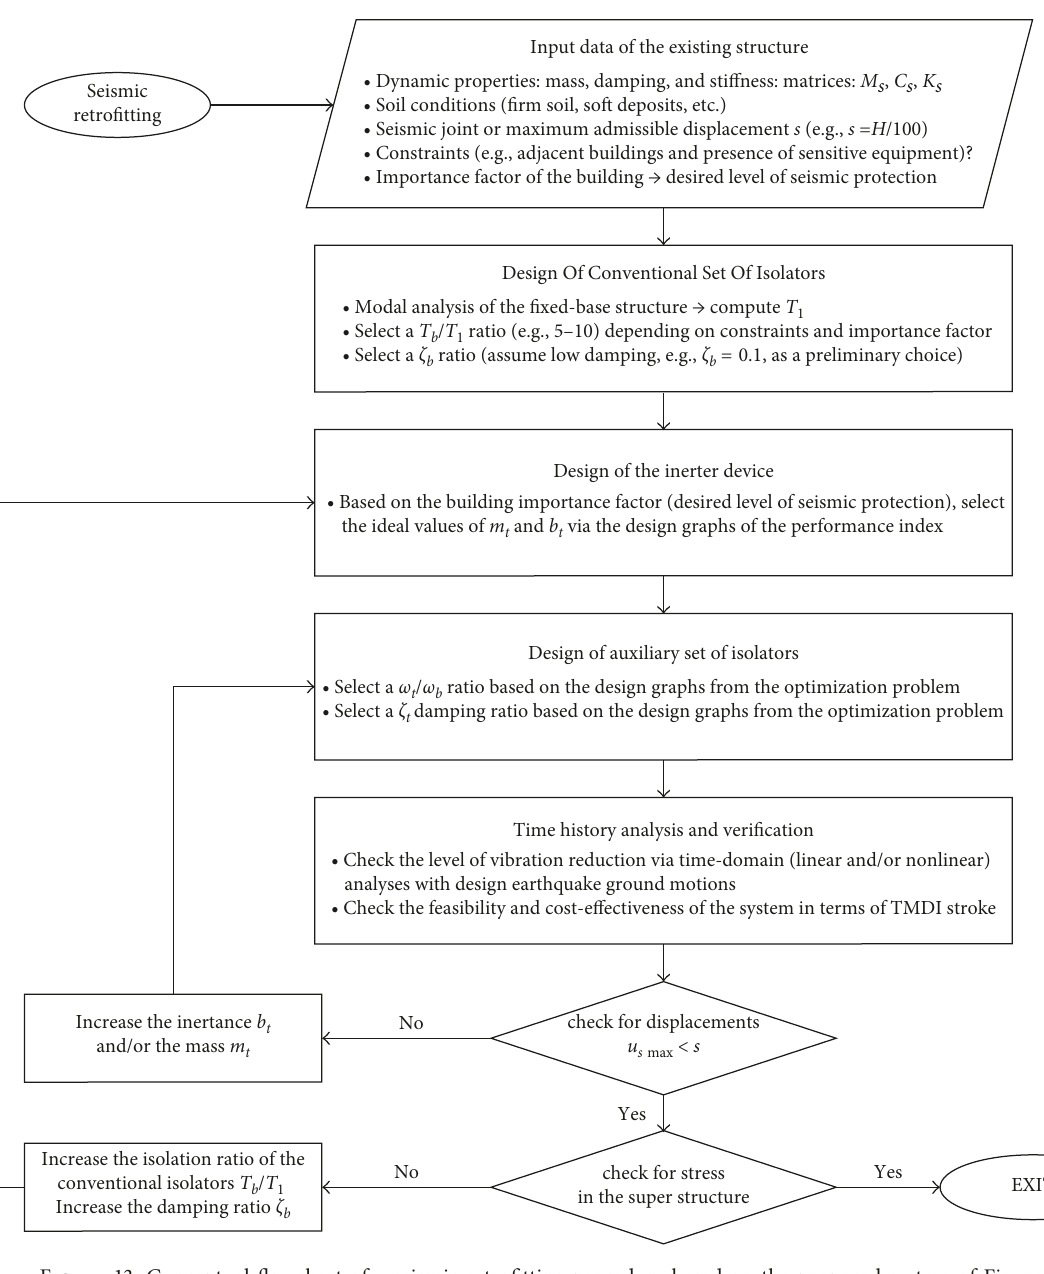
Figure 13: Conceptual flowchart of a seismic retrofitting procedure based on the proposed system of Figure